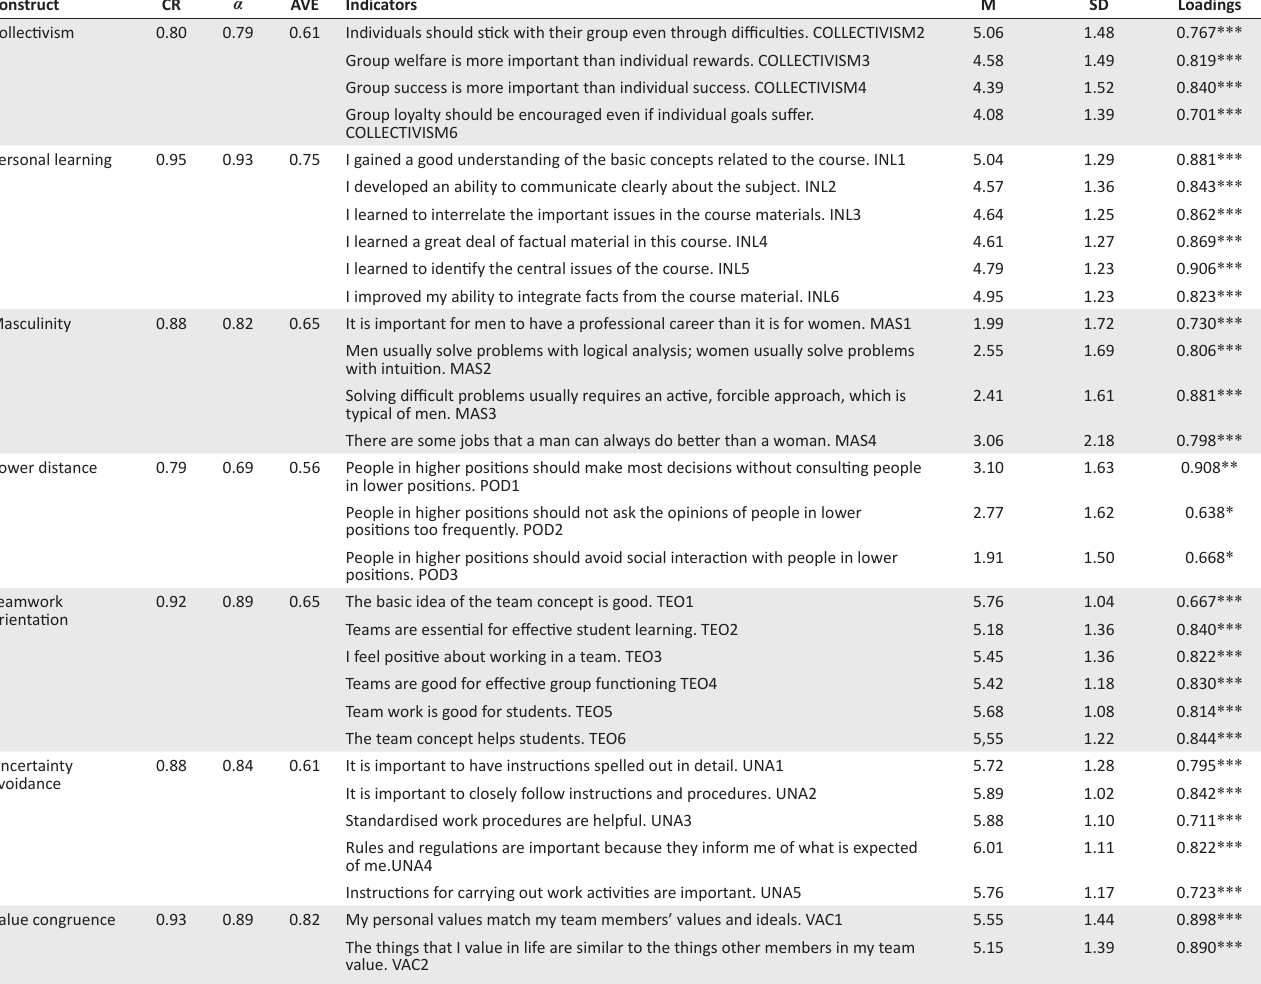
TABLE 2: Loadings, composite reliability and average variance extracted.